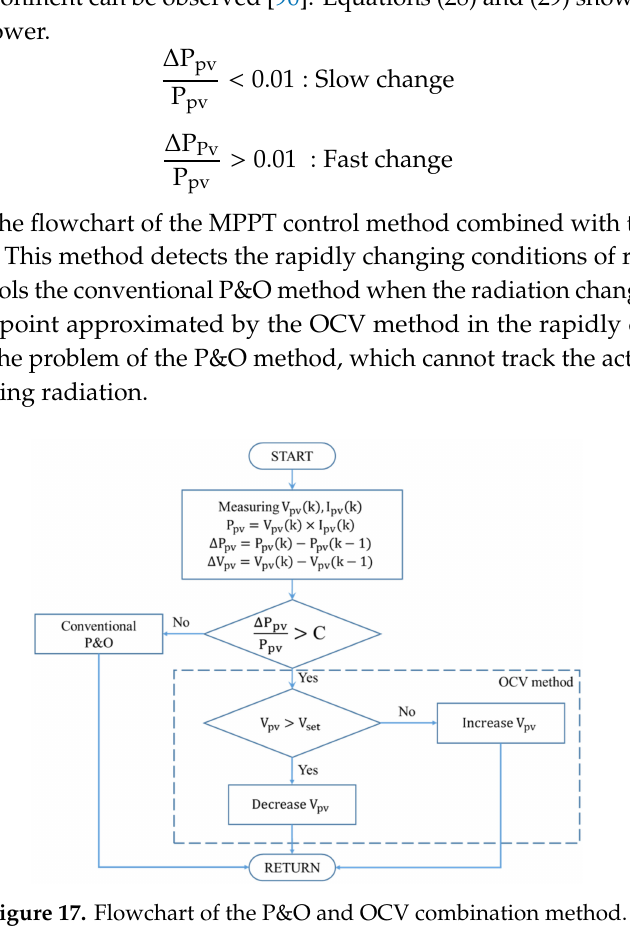
Figure 17. Flowchart of the P&O and OCV combination